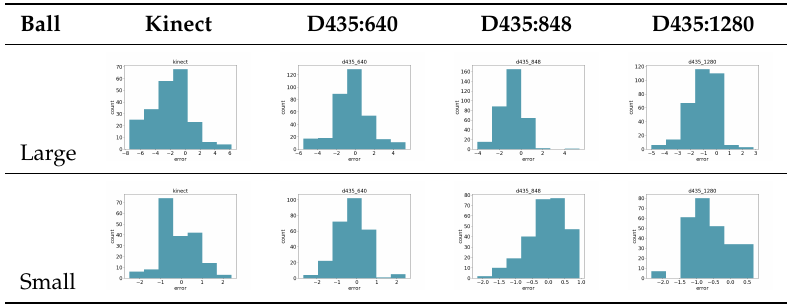
Table 7. Error distribution.